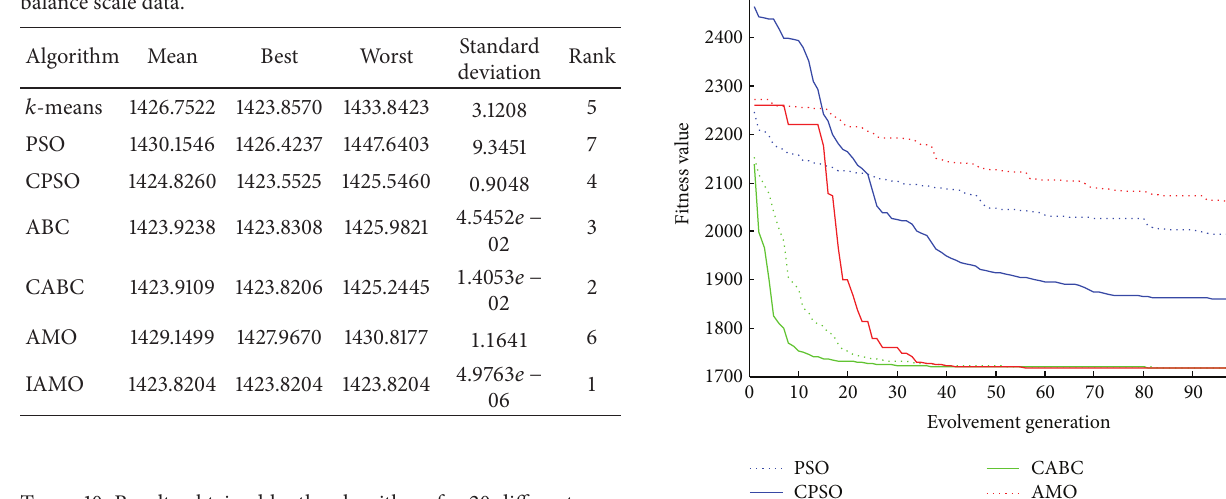
Table 10: Results obtained by the algorithms for 20 different runs on cancer data.